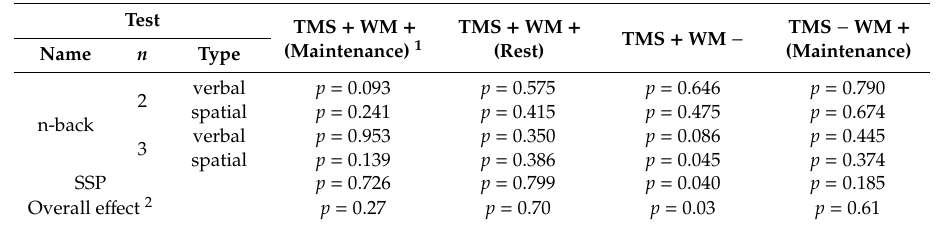
Table 2. Di ff erences between test scores after HF rTMS protocols (Wilcoxon test) and the overall e ff ect of each protocol (Fisher’s p -value synthesis).